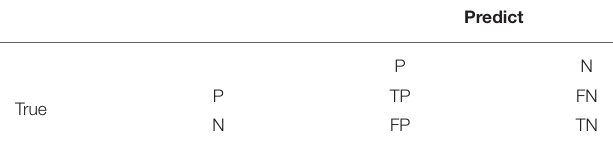
TABLE 3 | The specific representation of each parameter in the performance metrics.